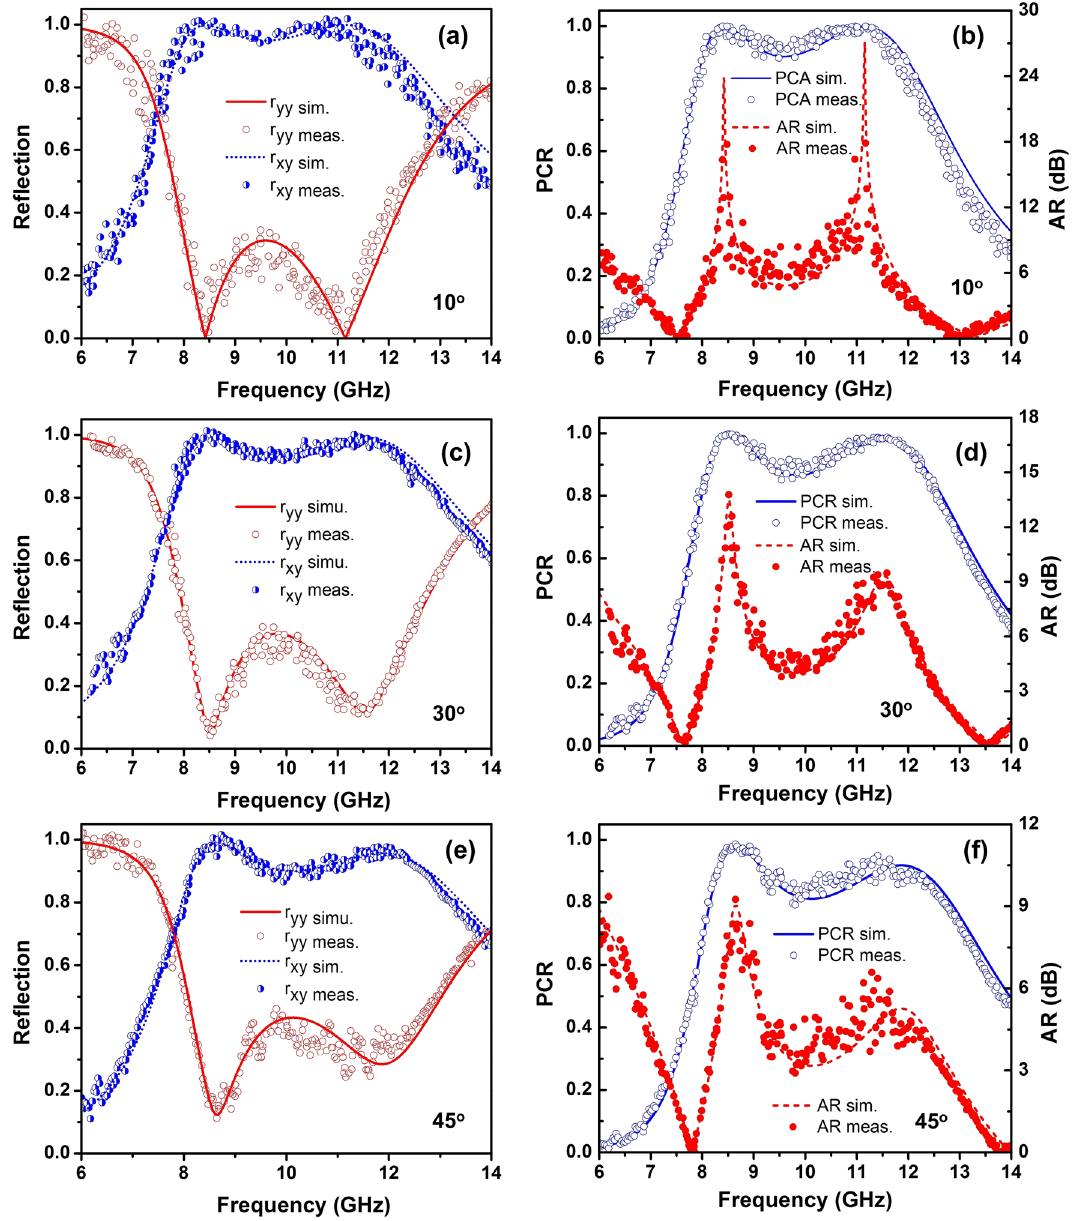
Figure 12. ( a , c , e ) Magnitude of simulated and measured co- and cross-polarized reflection coefficients and ( b , d , f ) PCR and AR of the proposed polarization converter under different incident angles of 10 ◦ , 30 ◦ , and 45 ◦ ,